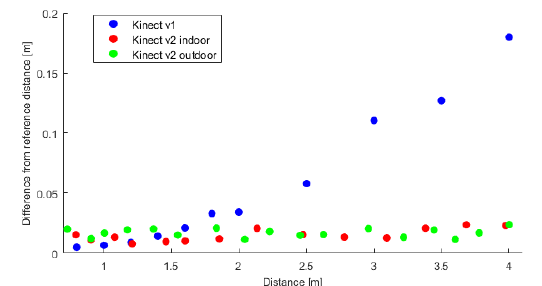
Figure 2. Estimation of the error committed by Kinect sensors as a function of the distance between the object and the device